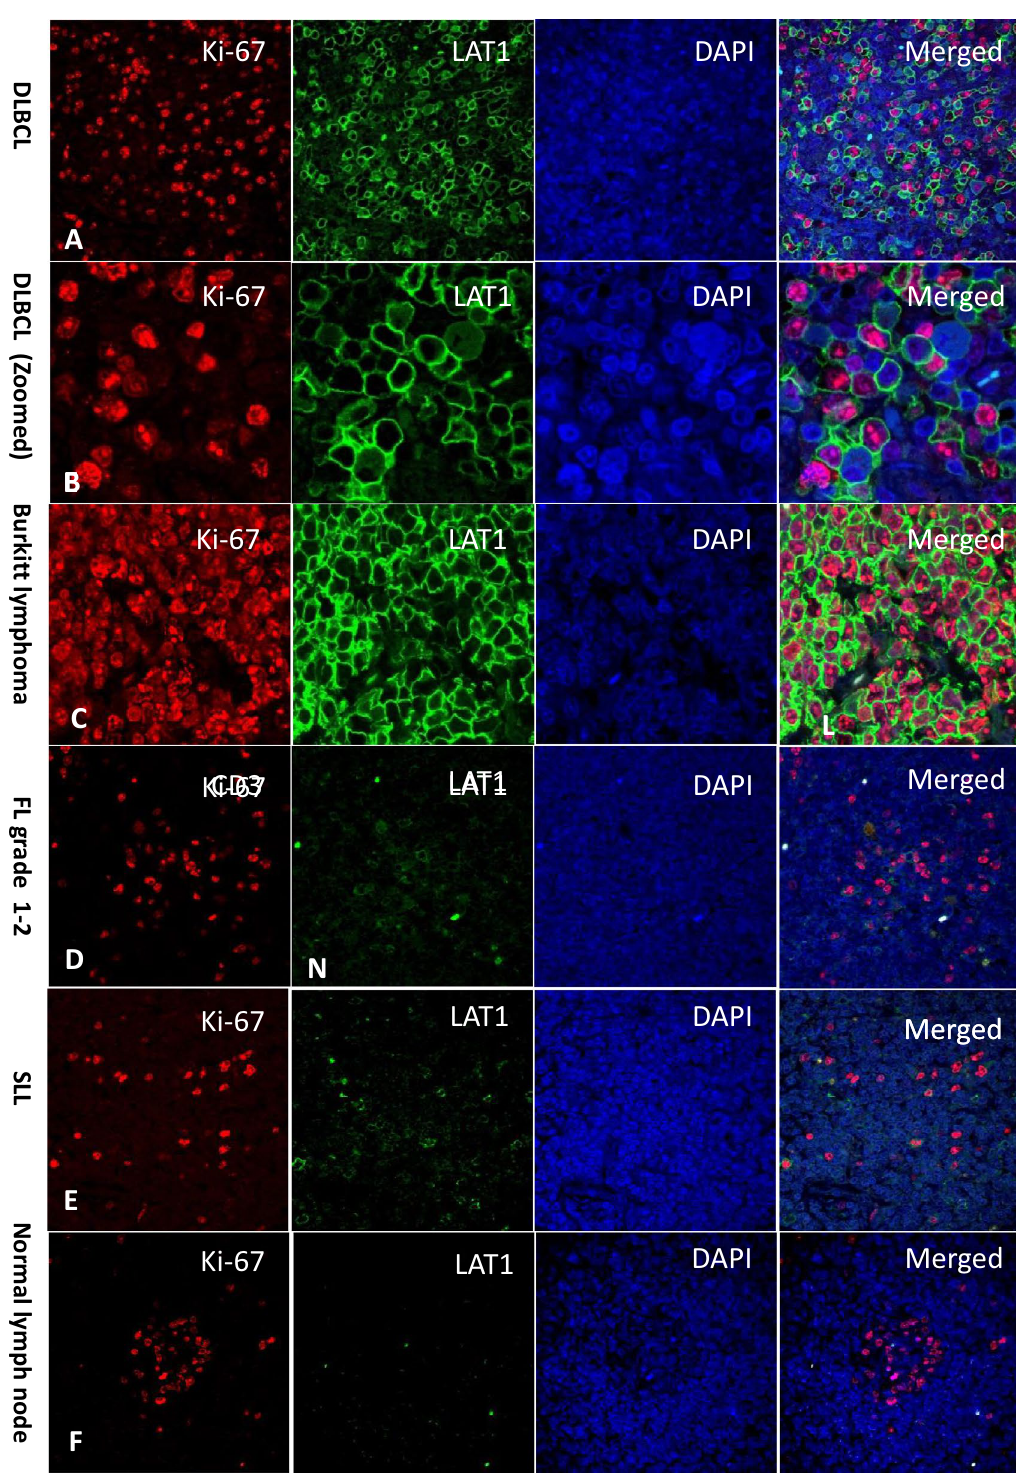
Figure 2. Representative images of Immunofluorescence double staining with LAT1 and Ki-67 of lymphoma cells. ( A ) Immunostaining of DLBCL tissue with anti-LAT1 antibody (red) or anti-Ki67 antibody (green). Nuclei were counter-stained by DAPI. ( B ) Zoomed images of the DLBCL tissue. ( C ) Immunostaining of Burkitt lymphoma. ( D ) Immunostaining of the follicular lymphoma cells. ( E ) Immunostaining of the SLL tissue. ( F ) Immunostaining of the normal lymph node tissue as a negative control. Scale bar, 50